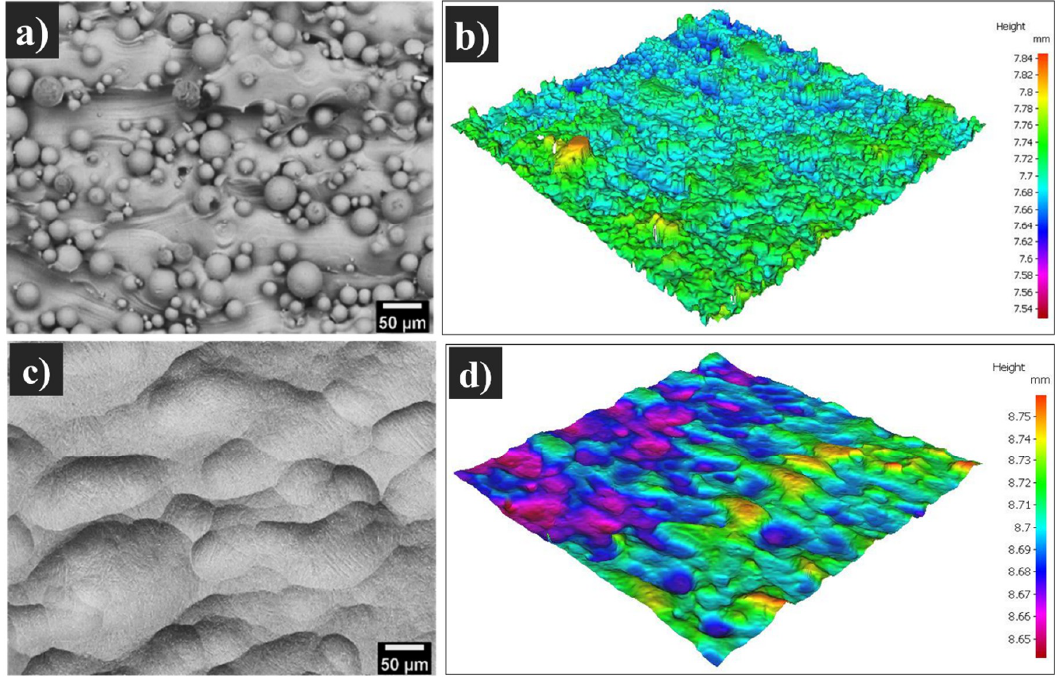
Figure 8. SEM micrographs and Alicona map of the top surfaces of ( a , b ) as‐fabricated Ti‐6Al‐4V samples containing partially melted particles and ( c , d ) vertical condition after HIP + chemical